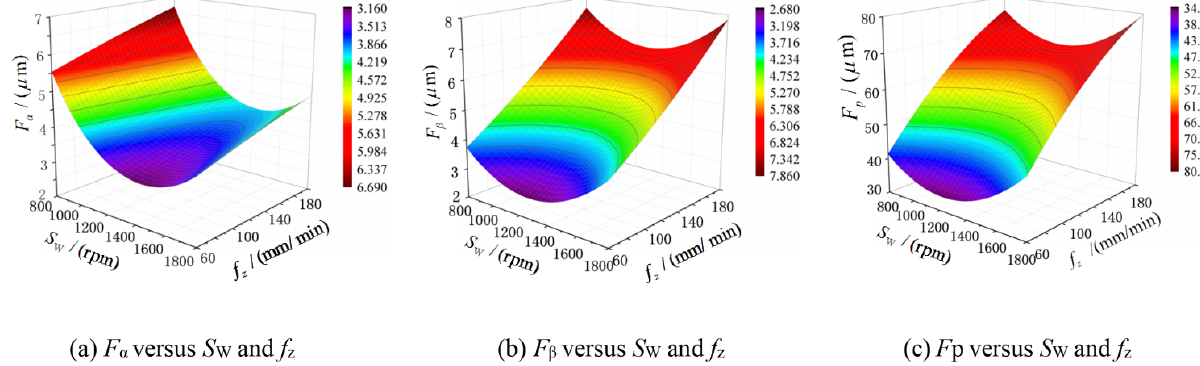
Figure 5. The influence roles of each IGPH process parameter on the gear profile deviations.